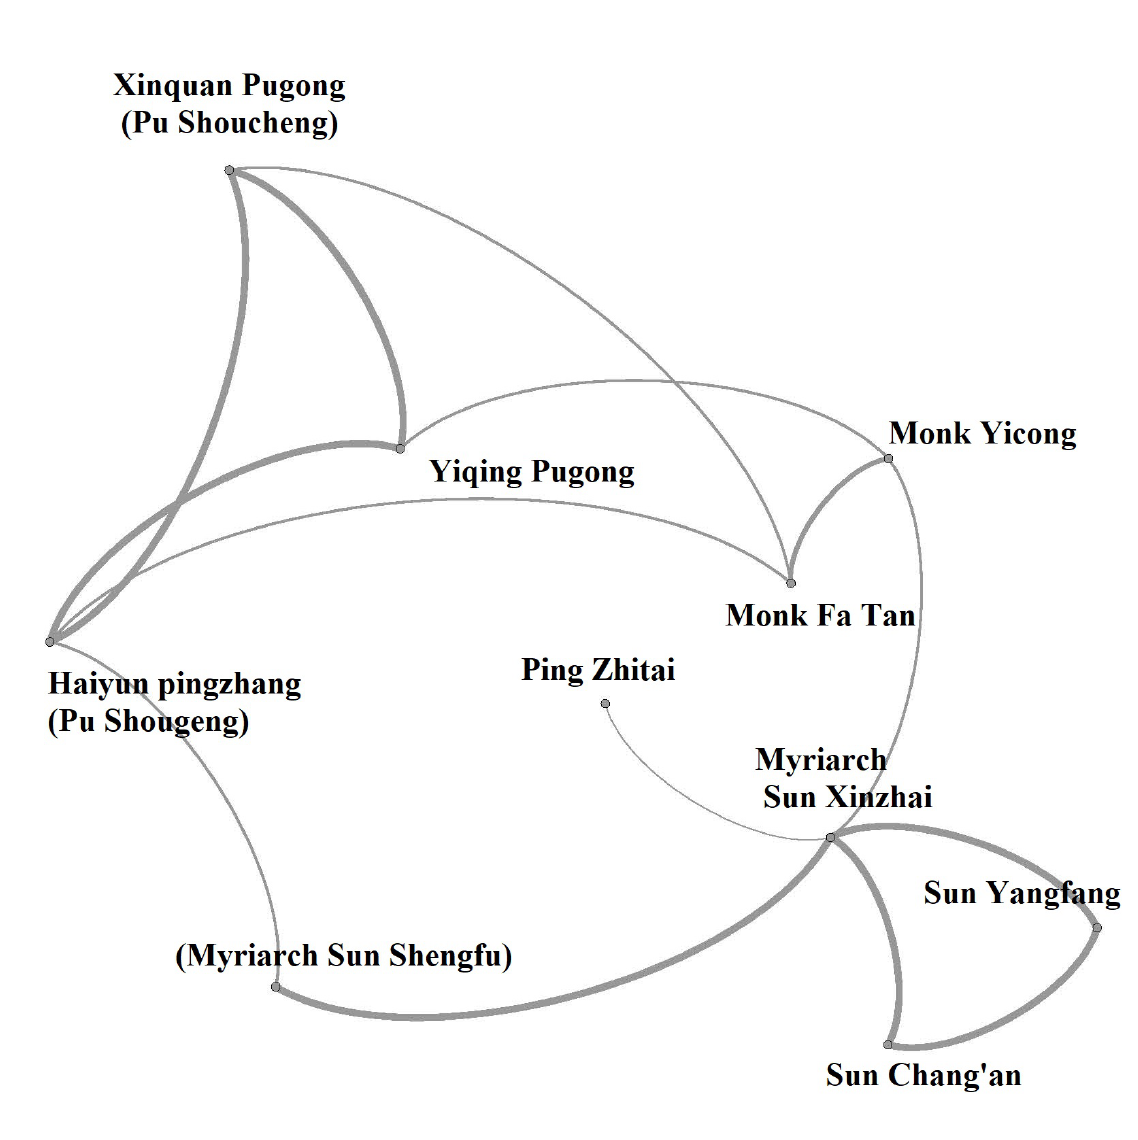
Figure 5 Social networks relating to the reconstruction of the temples at Chunyang Cave in Qingyuan Mountain. Source: Ding and Zheng (2003), 53-54. Software: